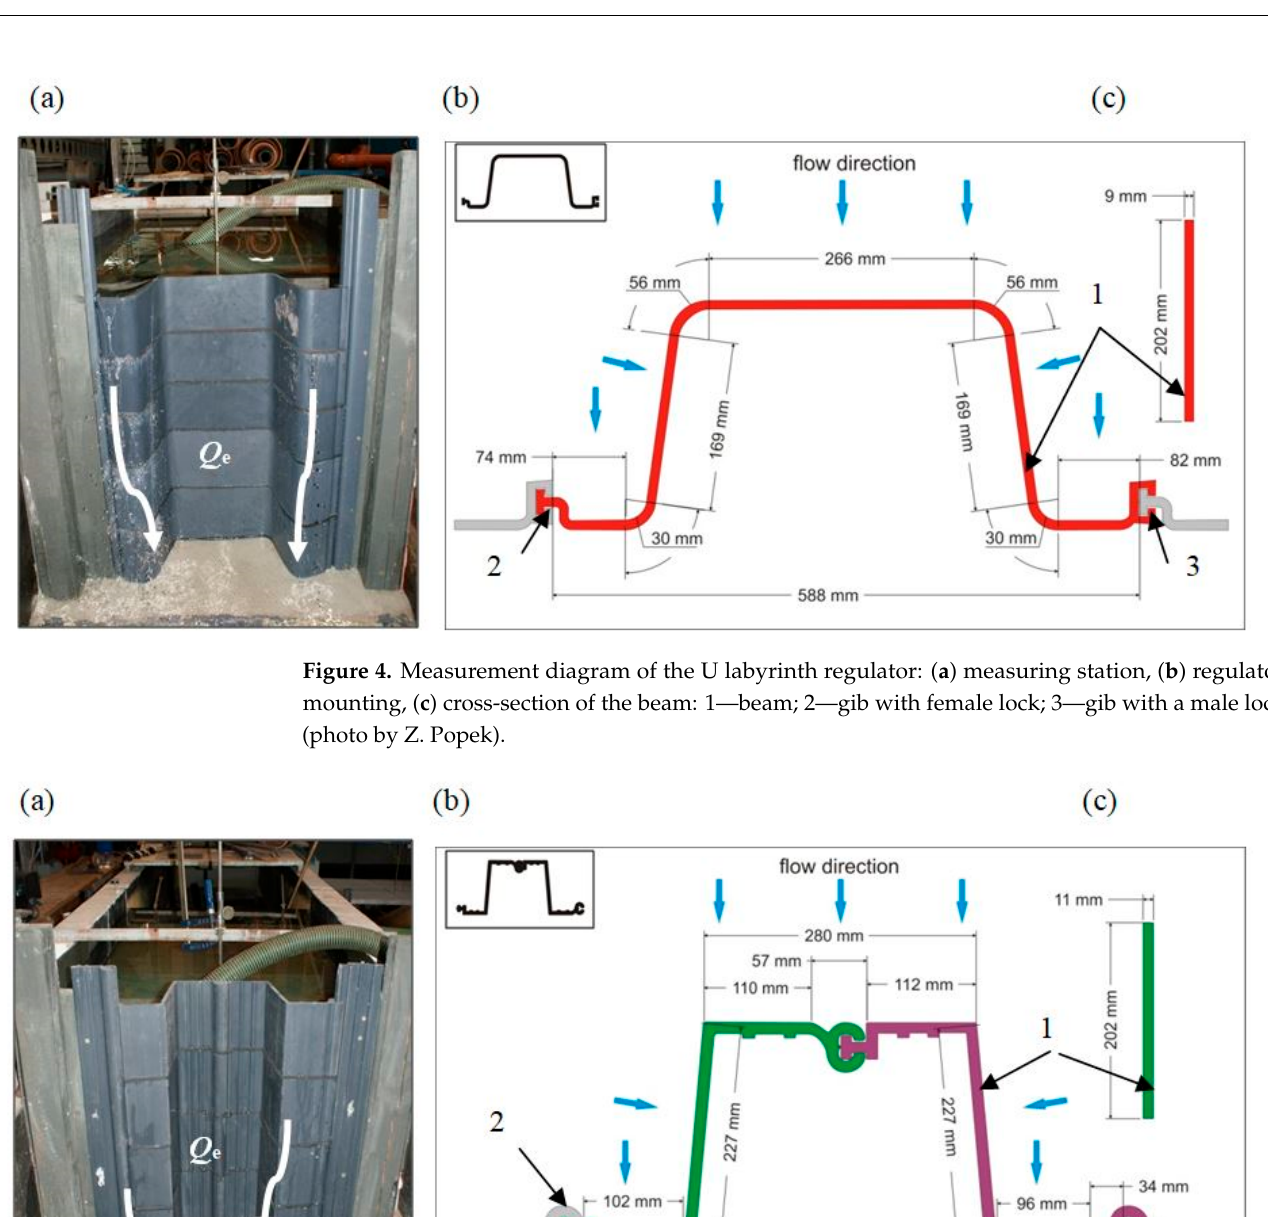
6 of 16 Figure 3. Measurement scheme of the S rectilinear regulator ( a ) measuring station, ( b ) regulator mounting, ( c ) cross-section of the beam: 1—beam; 2—gib; 3—regulator sill (photo by J. Urba ń ski).